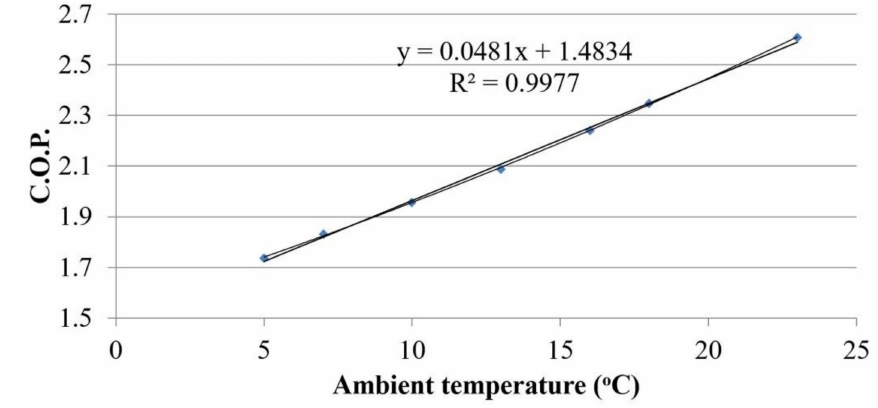
Figure 5. Typical COP fluctuation curve versus the ambient outdoor temperature for the existing air-to-air heat pumps employed for the swimming pools heating.